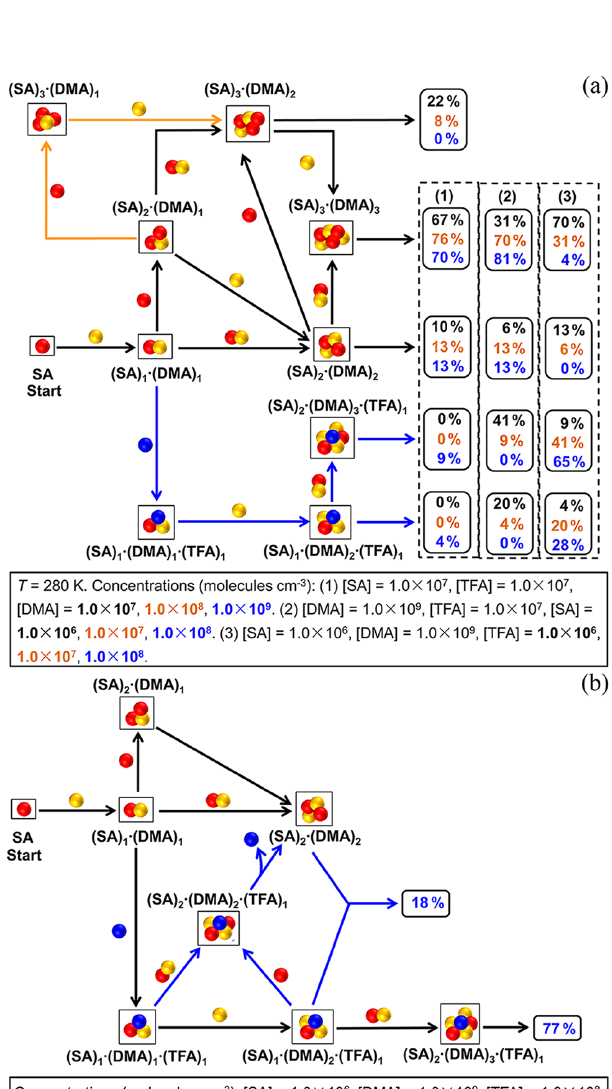
Figure 4. (a) Main cluster formation pathways of SA–DMA–TFA clusters at different [DMA], [SA], and [TFA]. The values of contri- bution shown in the right frames in black, orange, and blue are cor- responding to the contributions at (1) [DMA] of 1 . 0 × 10 7 , 1 . 0 × 10 8 and 1 . 0 × 10 9 molec.cm − 3 , respectively, (2) [SA] of 1 . 0 × 10 6 , 1 . 0 × 10 7 and 1 . 0 × 10 8 molec.cm − 3 , respectively, and (3) [TFA] of 1 . 0 × 10 6 , 1 . 0 × 10 7 and 1 . 0 × 10 8 molec.cm − 3 , respectively. Black arrows show the common pathways present at all the stud- ied [DMA]. Orange and blue arrows show the additional path- ways present at [DMA] = 1 . 0 × 10 7 molec.cm − 3 and [DMA] = 1 . 0 × 10 9 molec.cm − 3 . (b) Main cluster formation pathways of SA– DMA–TFA clusters at 260K. Black arrows show the common path- ways present at both 260 and 280K. Blue arrows show the addi- tional pathways present at 260K compared with